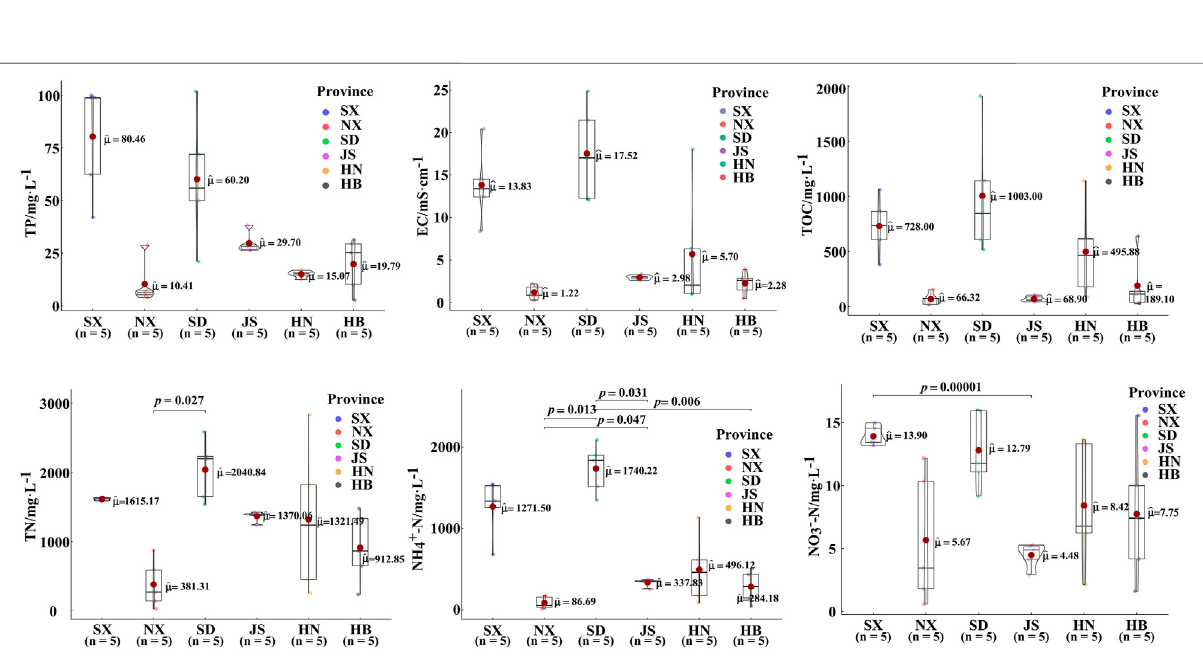
( Figure 3 ). The results were higher than those in previous studies,